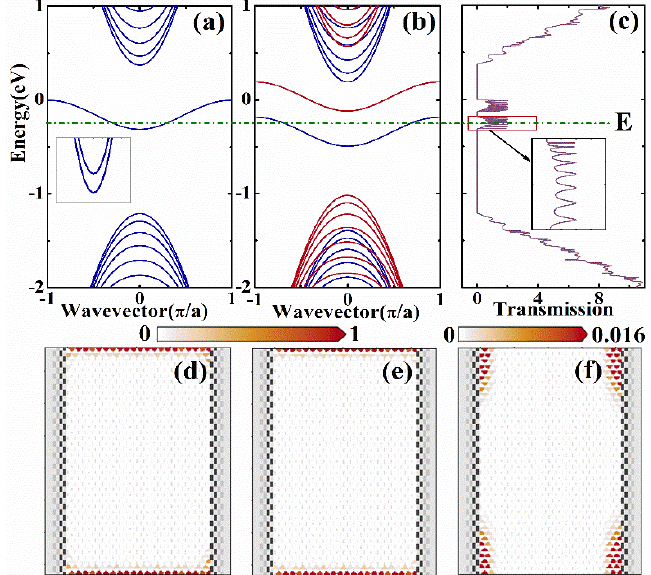
Figure 2. The band structures for ( a ) pristine zigzag phosphorene nanoribbon and ( b ) ferromagnetic zigzag phosphorene nanoribbon. ( c ) The transmission of the device. ( d – f ) LDOS of the device for total, spin-down and spin-up electrons, respectively, with E = − 0.25 (green dashed dotted line).